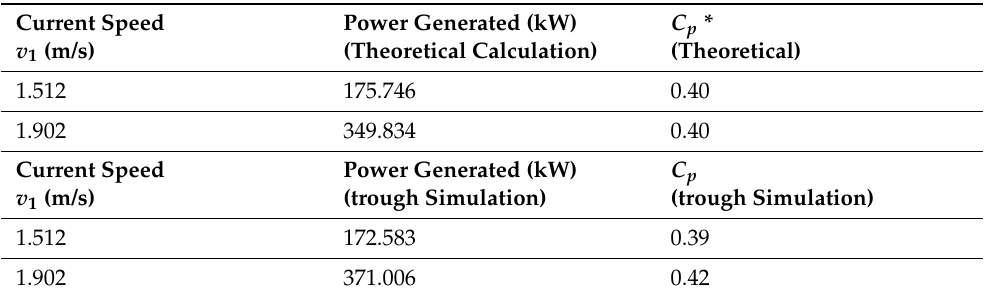
Table 14. Comparison of theoretical and simulated results. * This value of Cp is just an approximation due to lack of